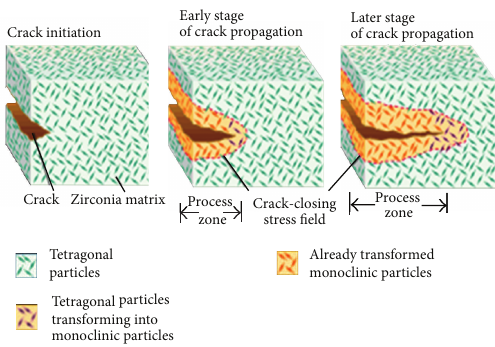
Figure 5: Phase transformation in Zirconia. Source: